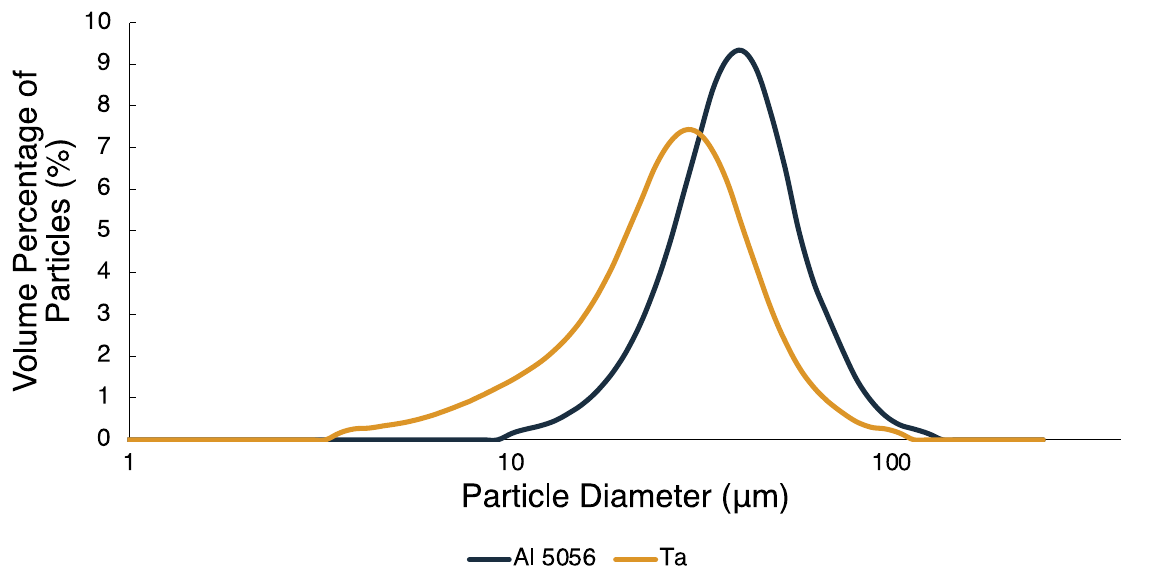
Figure 8. PSD histogram line plots for a representative sample of the Al 5056 and Ta powders. Particle morphology also plays a critical role in moisture content and flowability val- ues observed with the Al 5056 and Ta powders. As listed in Table 2, the primary morphol- ogy parameters considered here for both powder types are 𝑆𝑝ℎ𝑒𝑟𝑖𝑐𝑖𝑡𝑦 and 𝑆𝐴 𝑉⁄